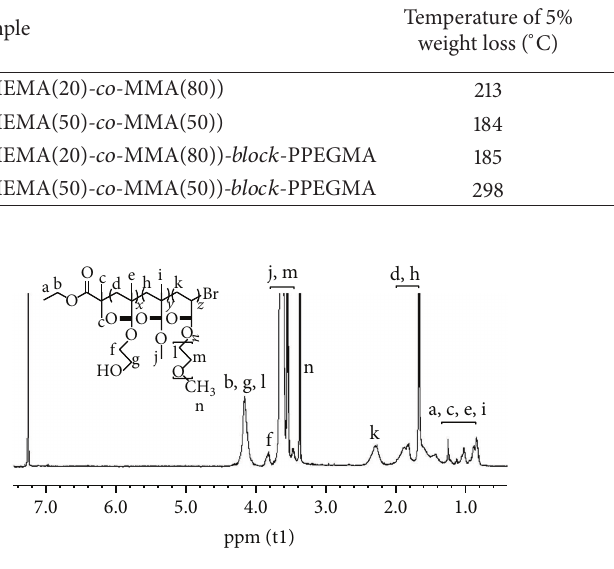
Figure 5: The 1 H-NMR spectrum of P(HEMA- co -MMA)- block - PPEGMA ( 2b, 2d ).